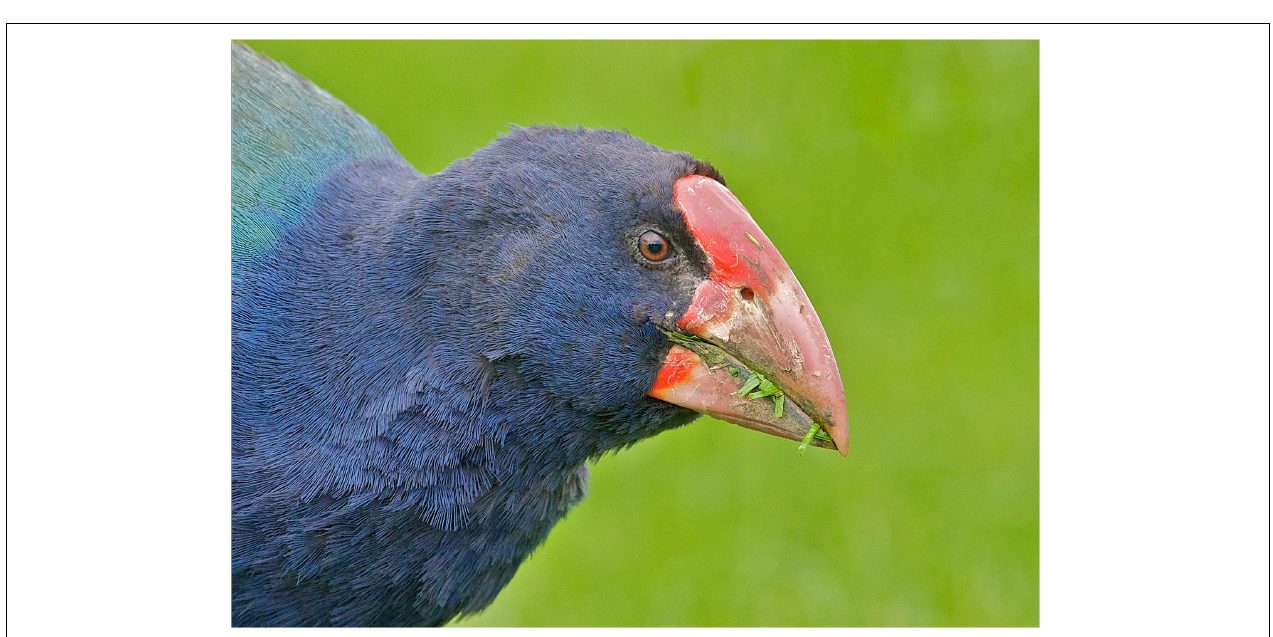
FIGURE 5 | Juvenile upper beaks of Gastornis russelli/parisiensis R2583 (A,C) and Sylviornis neocaledoniae NCP-263 (B,D) . (A,B) Left lateral views. (C,D) Ventral views. White arrows in (C) indicate large pits similar to those in Omorhamphus storchii , which are also vascular openings. In (D) : lt, lateral tomial crest; mt, medial tomial crest; l op, large openings of vascular canals. Scale bars, 10 mm.